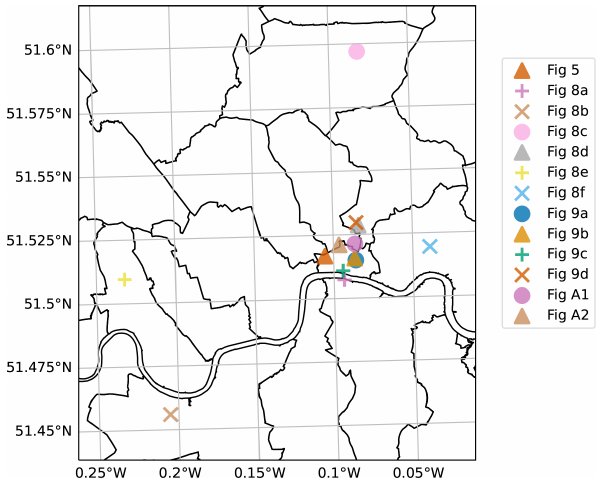
Figure A3. Locations of images in this